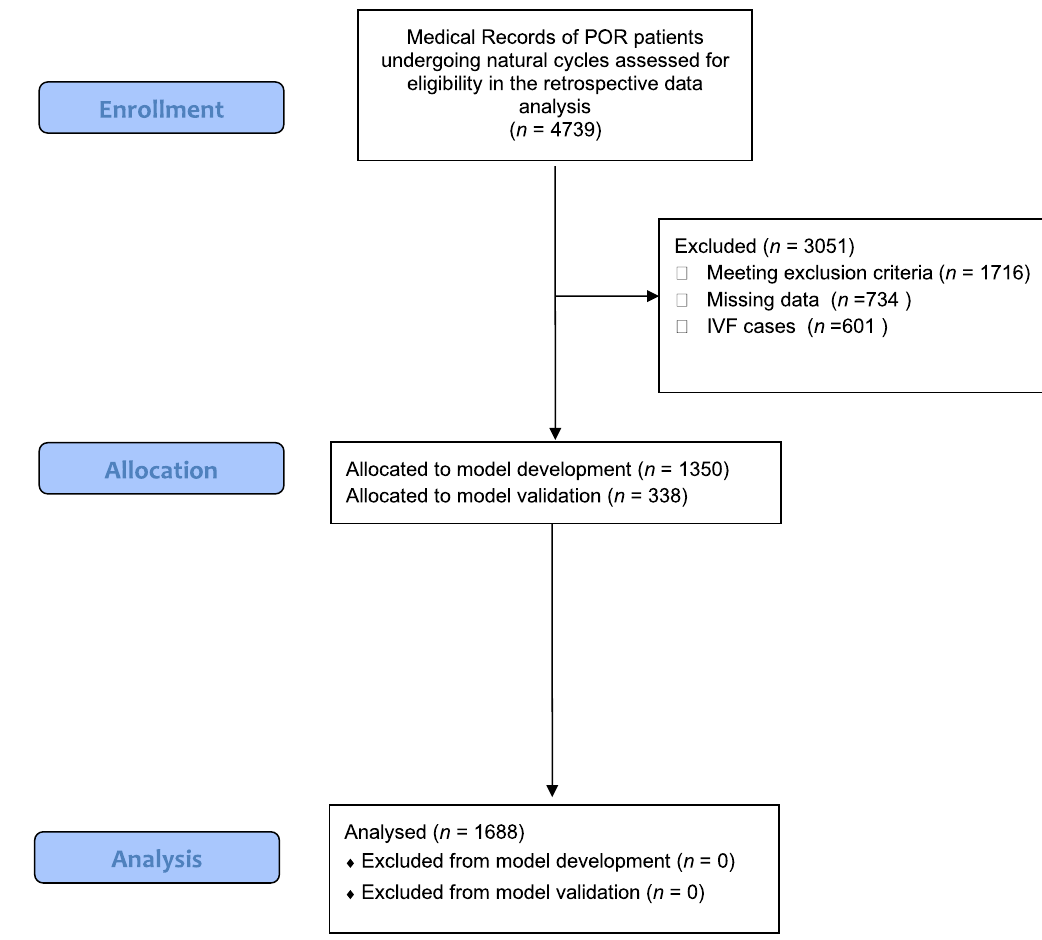
Figure 3. Modified version of CONSORT Flow Diagram providing a detailed outline on participants’ screening, allocation and final